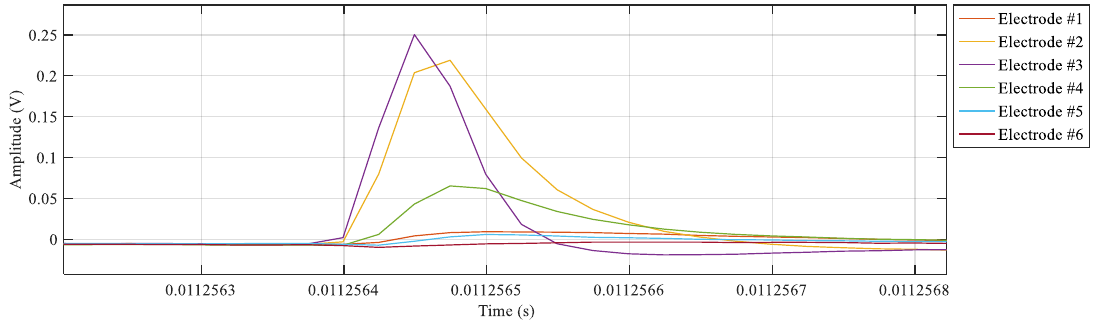
Figure 12. Measured voltage from the monitor and the electrodes, joint #2 (at nominal voltage).